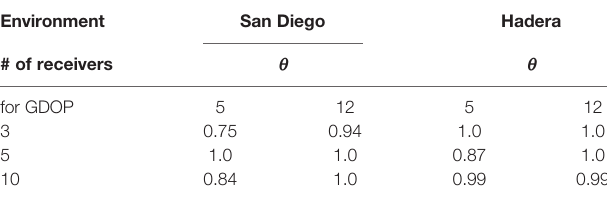
TABLE 4 | Ratio between the coverage and the usable area, q for the deployment of 3, 5 and 10 receivers for San Diego and the Hadera power station areas, for GDOP = 5 and GDOP =